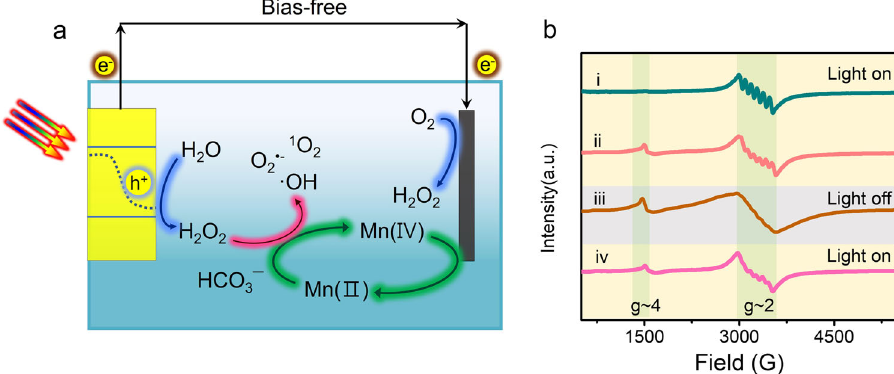
Fig. 1 | Self-cycled photo-Fenton-like system with recycled Mn species. a Scheme of the Self-cycled photo-Fenton-like system with recycled Mn species. b EPR response of Mn species: (i) Mn(II) signal in the initial 2min under AM 1.5